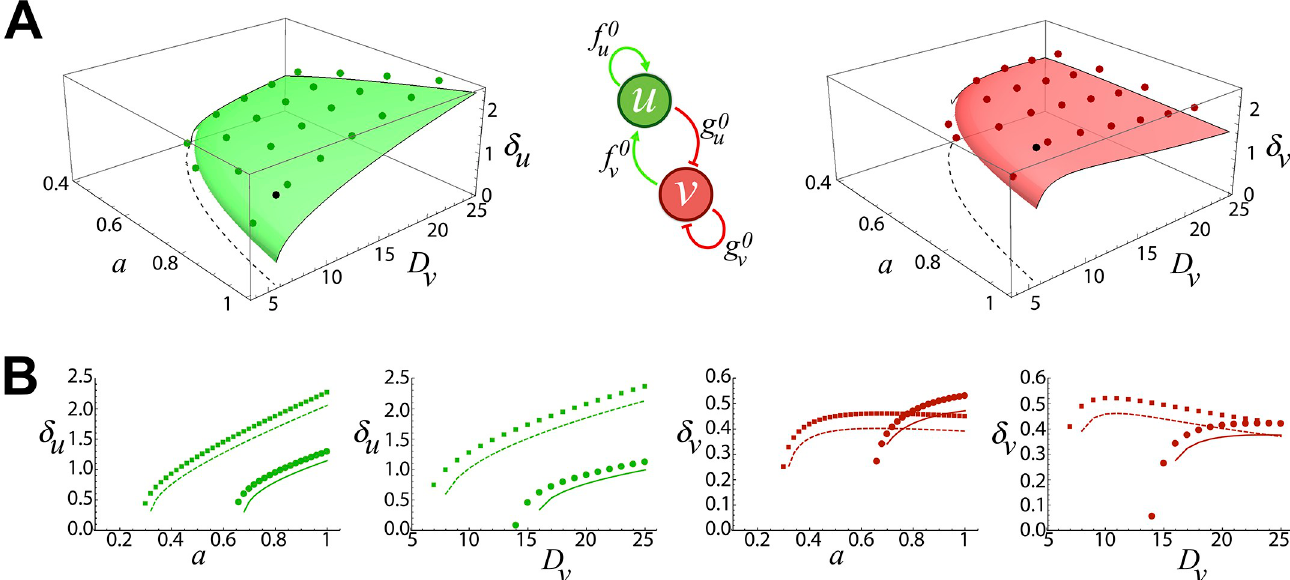
Fig 1. A : Amplitudes of the pattern δ (left) and δ (right) in the parameter space a - D obtained by our approach (continuous surfaces) and in numerical u v v simulations (circles) for the activator, u (green in all panels), inhibitor, v , (red in all panels) system described in the main text (Eq 15). The black dashed line indicates the patterning separatrix, Eq (14), and the black circle indicates the parameter values used to obtain the pattern shown in Fig 2A. The central inset shows, graphically, the regulatory interactions between the species u and v as defined by the sign of the linear components, f 0 , f 0 , g 0 , and g 0 . B : Trajectories to sample the u v u v = 9, 20 (solid and dashed lines theoretical solutions. The symbols indicate simulations results and the lines the approximated solutions for fixed values of D v respectively) and increasing a , and for fixed values of a = 0.4, 0.9 (solid and dashed lines respectively) and increasing values of D v .